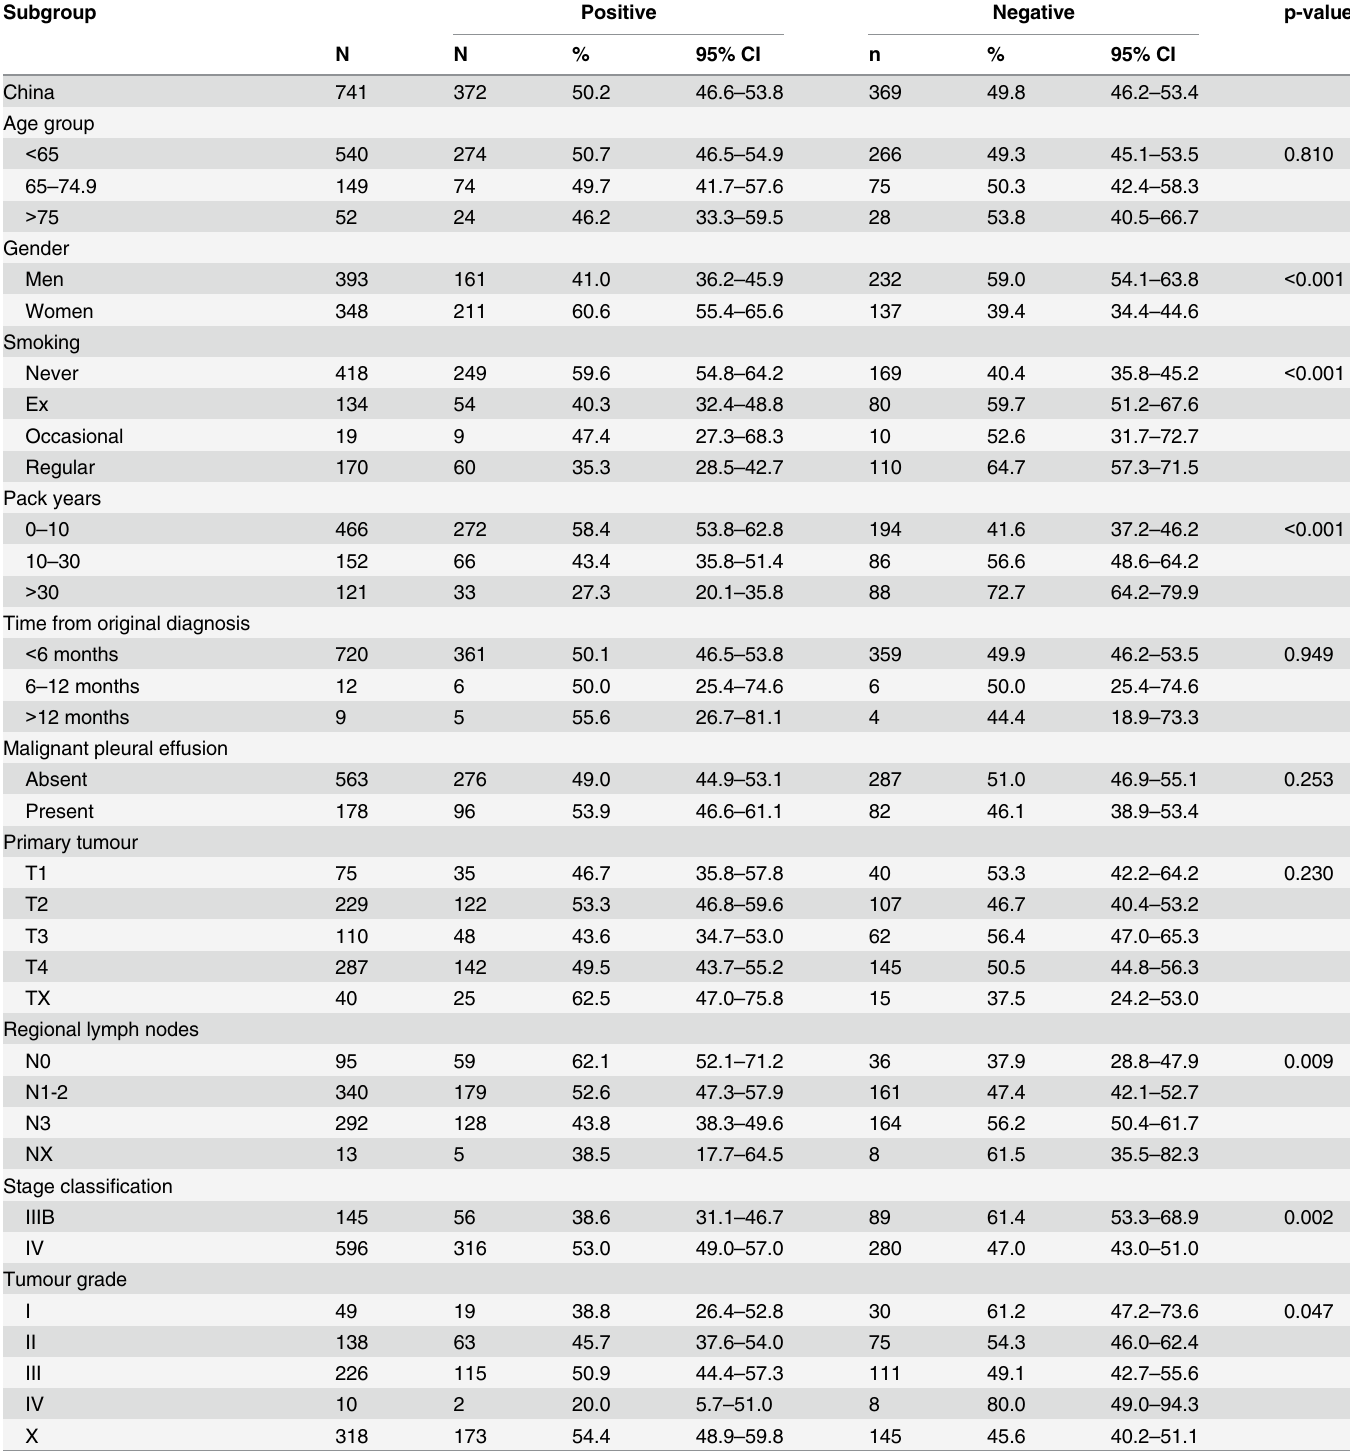
Table 1. Subgroups analysis for EGFR mutation testing